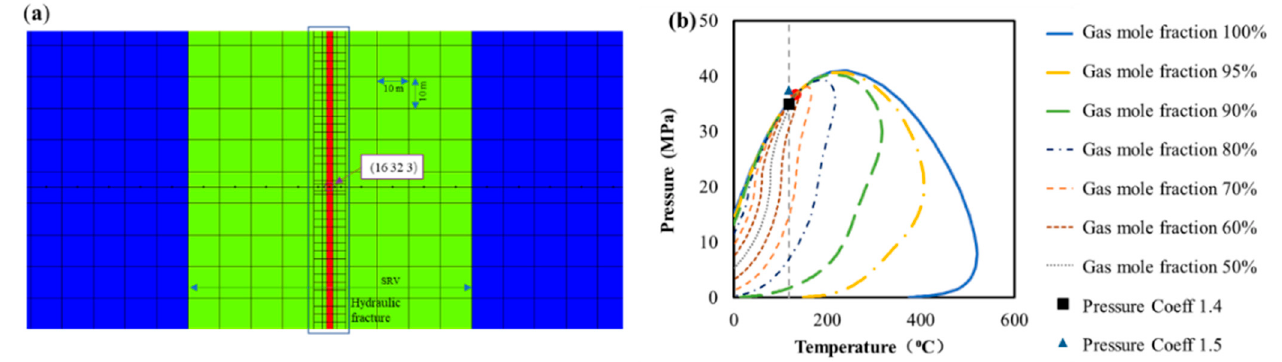
Figure 4. ( a ) Grid system for the one-stage hydraulic fractured reservoir model; ( b ) the volatile oil phase envelope with different gas mole fractions. Table 1. Model parameters of the one-stage fractured horizontal well.